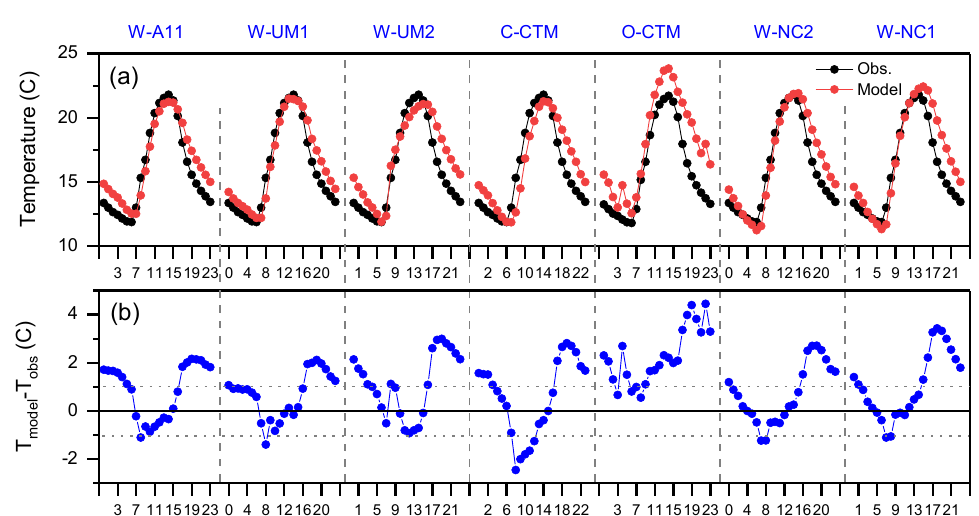
Figure 2. Diurnal composite ( a ) observed and simulated air temperature, and ( b ) hourly differences, over the 27-day SPS-II campaign at Westmead in autumn 2012.